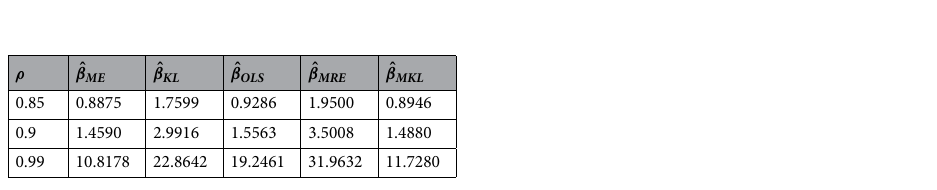
Table 13. Estimated MSE when σ